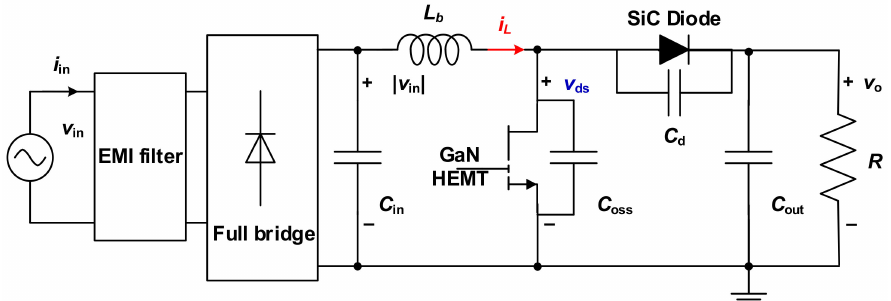
Figure 1. Boost PFC converter circuit with the GaN high-electron-mobility transistor (HEMT) and the SiC diode.